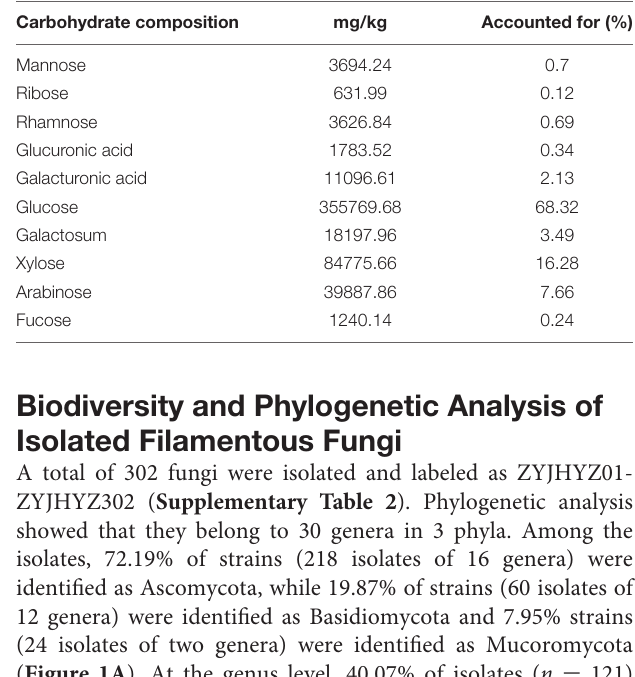
TABLE 1 | Table of carbohydrate composition of anti-biodegradable